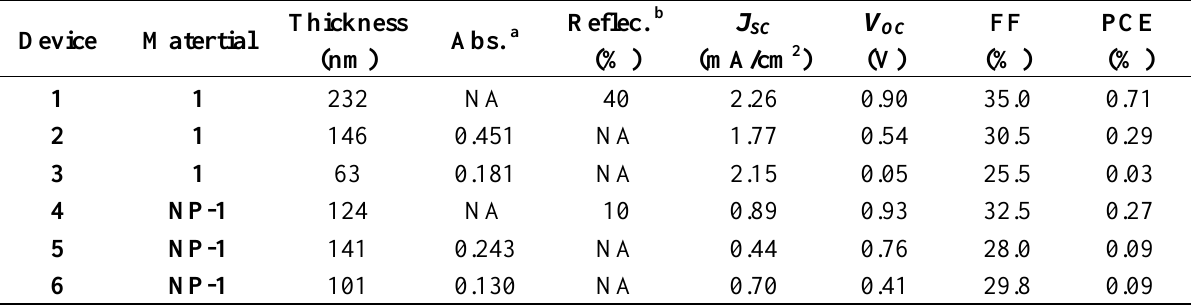
Table 1. A collection of the data obtained for all the devices, i.e. , thickness, absorption in the active layer, reflectance, device material, and photovoltaic properties: PCE, open circuit devices with the geometry glass/ITO/PEDOT:PSS/donor-[60]PCBM (1:1 w/w, 20 mg/mL)/Al and an active area of the devices of 0.25 cm 2 . The testing conditions were reported previously